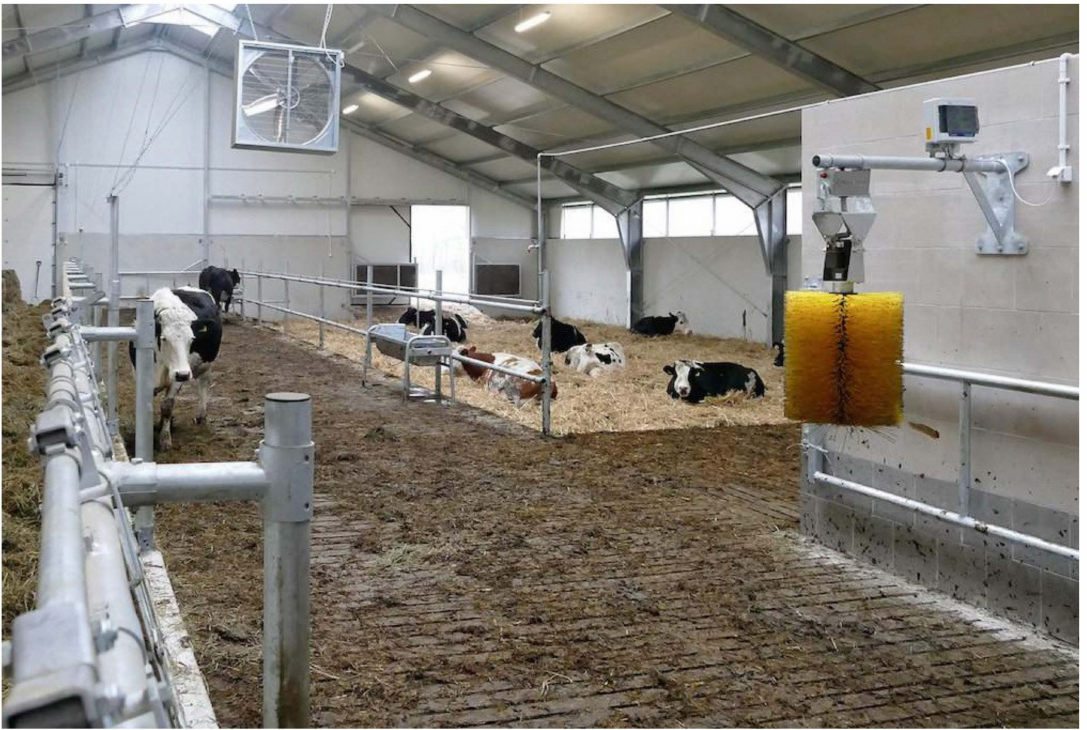
Figure 3. Open-pack barn with deep litter (A. Poniewa ˙